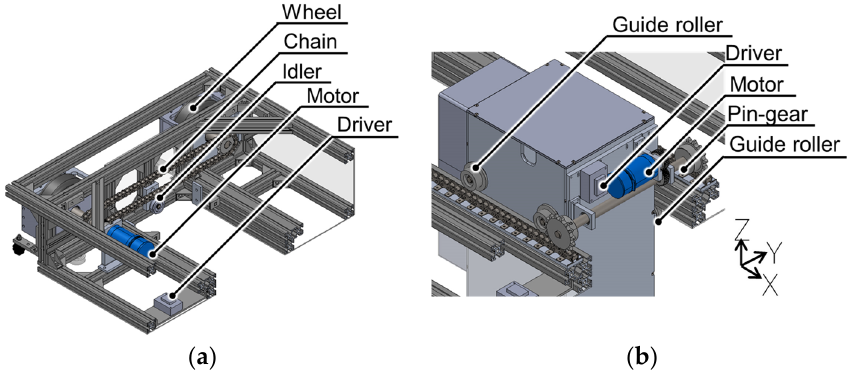
Figure 4. ( a ) Y-direction, ( b ) X-direction. CAD of the developed rail mechanism.